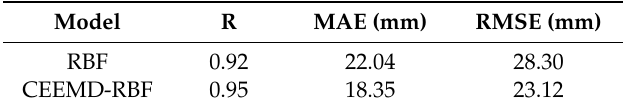
Table 1. Statistics of prediction results computed for RBF and CEEMD-RBF combined model.